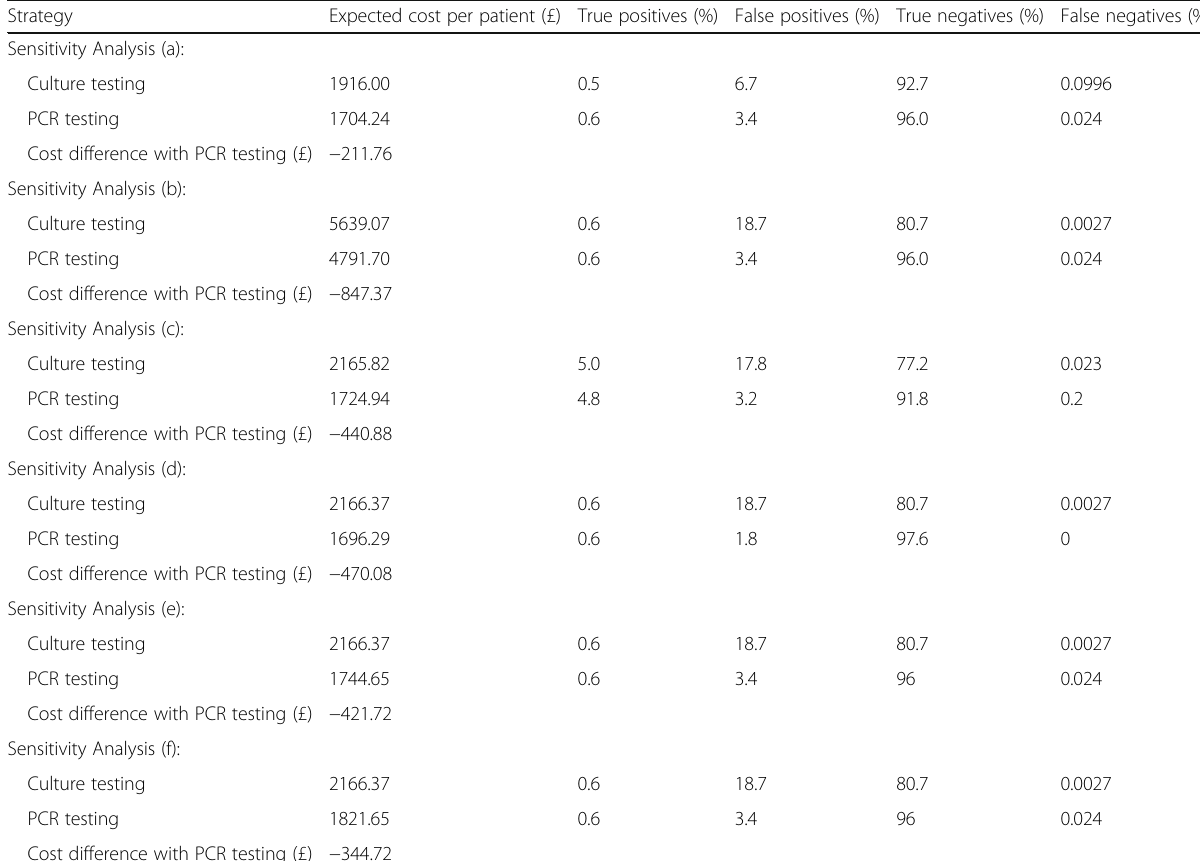
Table 3 Sensitivity analyses expected costs and test performance